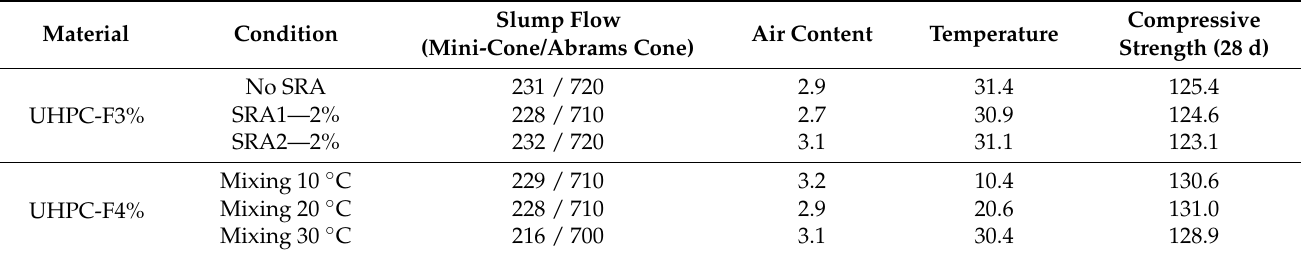
Table 2. Fresh state and hardened state properties.